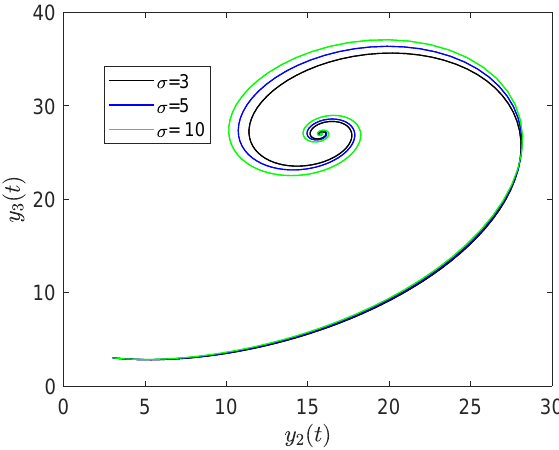
Figure 49. Phase portraits of y 2 and y 3 when varying σ .